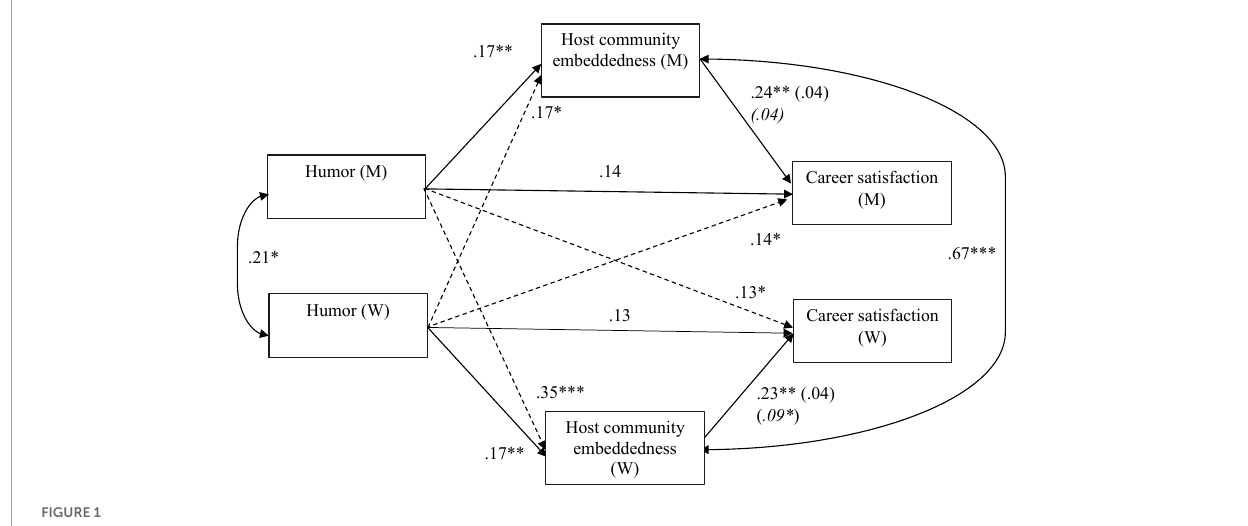
FIGURE1 Research results. ________: Actor effects. - - - - - -_: Partner effects. ∗ p < 0.05; ∗∗ p < 0.01; ∗∗∗ p < 0.001. Estimates of partner’s mediation effects are marked in italics in brackets. The actor paths was controlled for education, personal initiative, language proficiency, and duration in the host